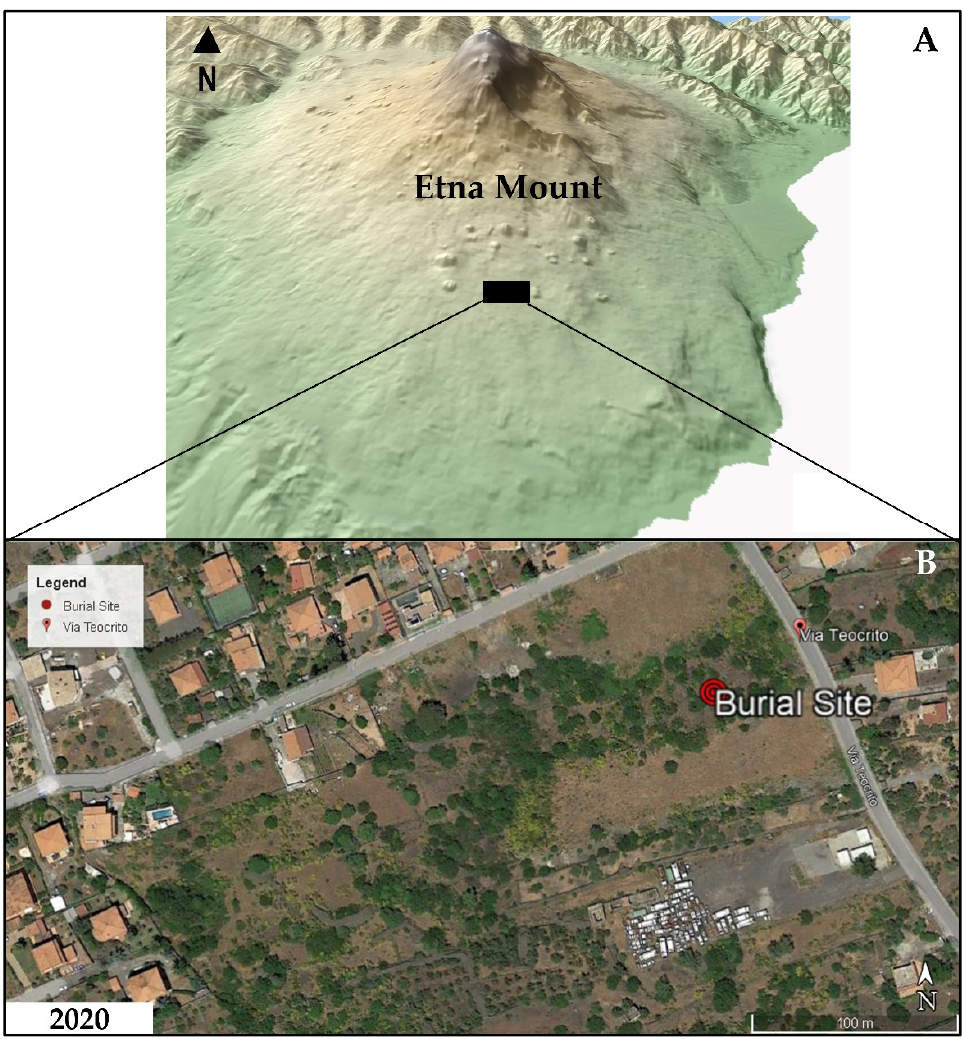
Figure 5. Localization of the burial site on the DEM of the Etna Mount ( A ) and on the satellite imagery ( B ).